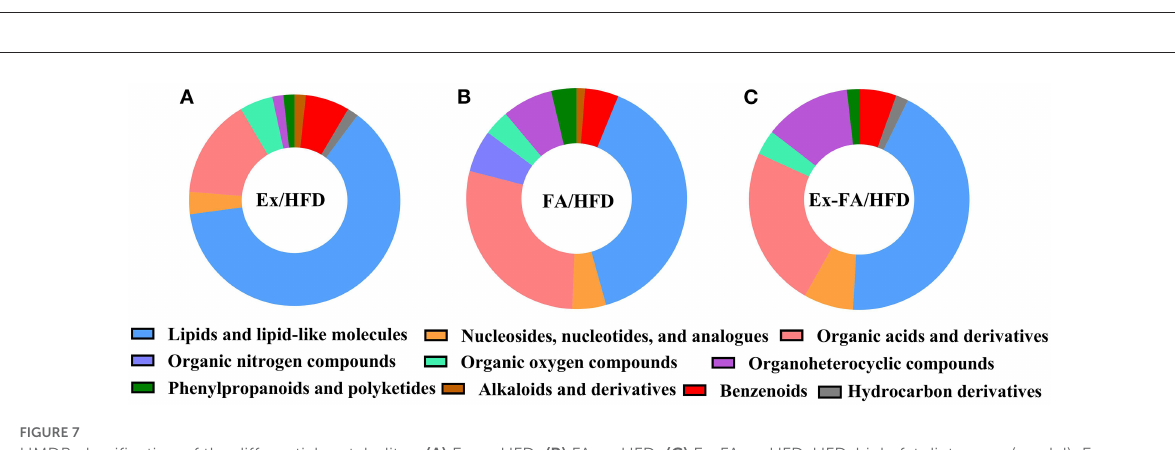
TG, TC, and FFA levels in the skeletal muscle were significantly increased by HFD treatment, while muscular TC and FFA levels were markedly reduced by FA supplementation (Table